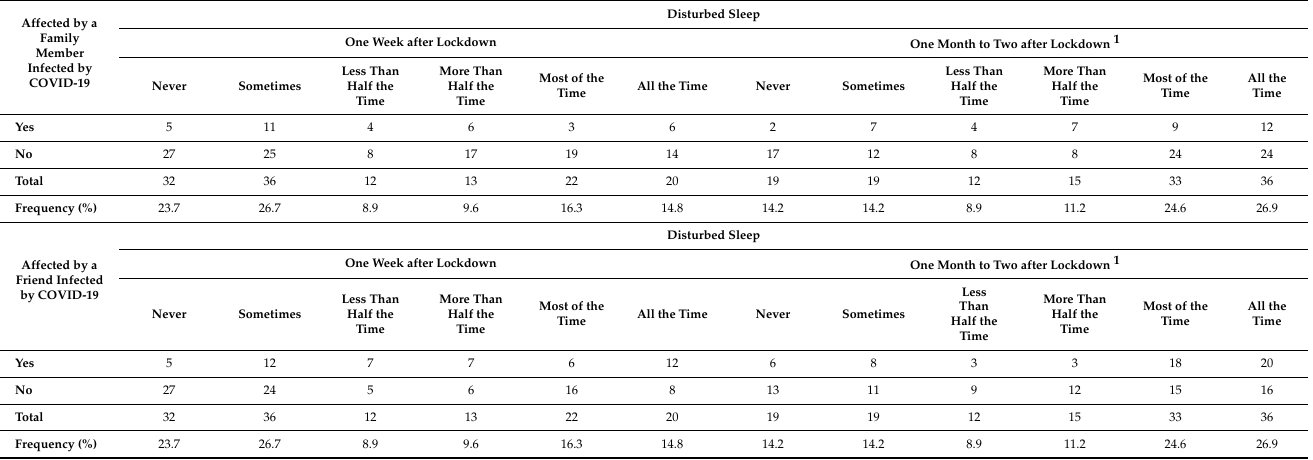
Table 5. Disturbed sleep and a family member or friend infected by